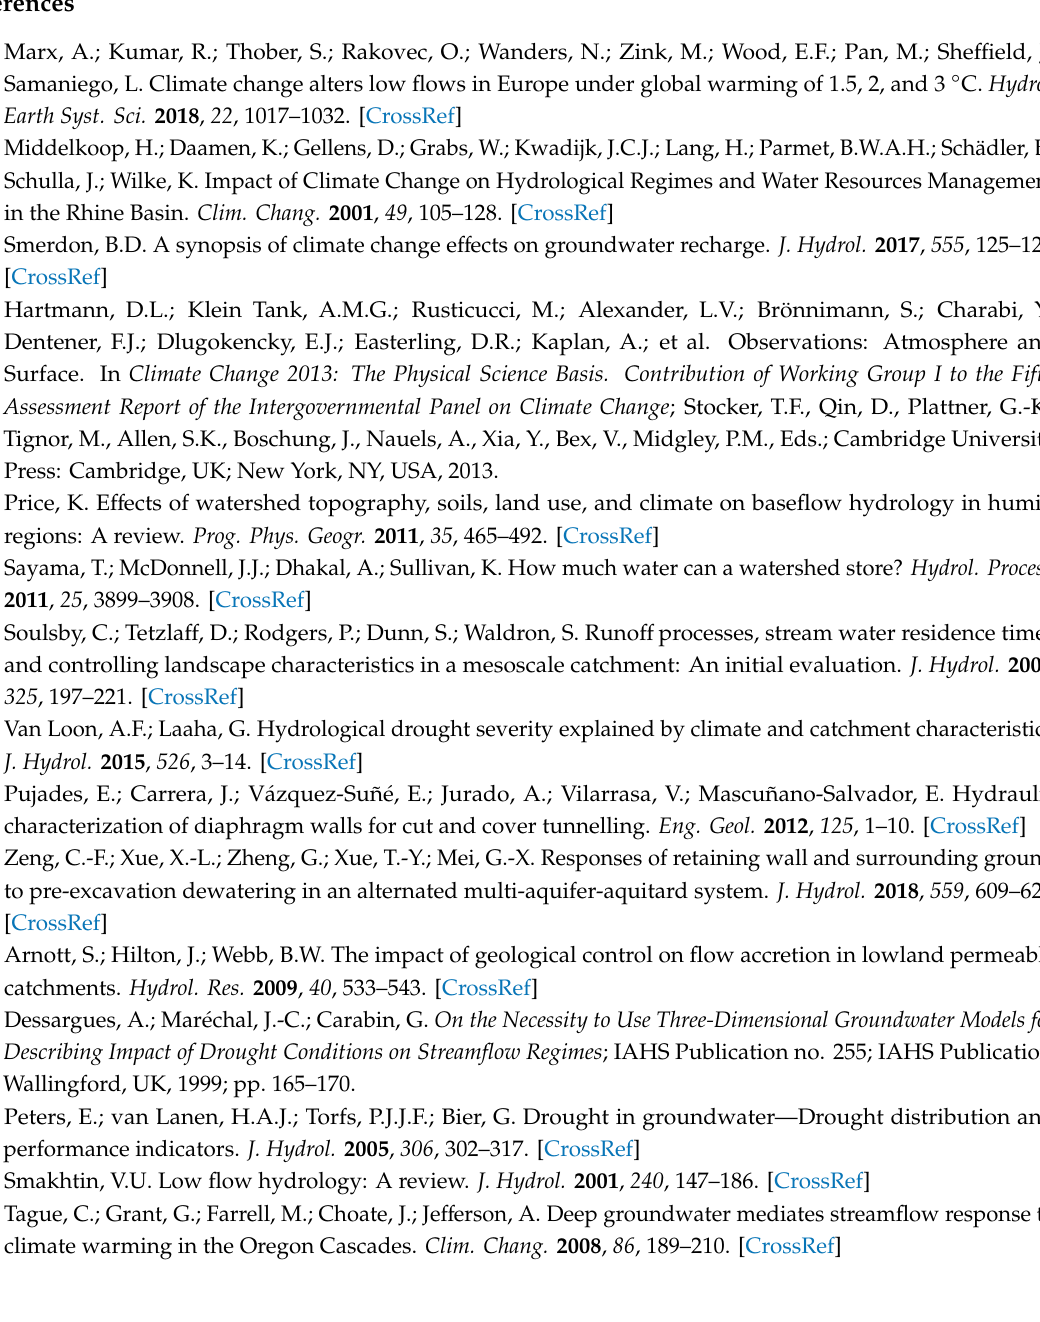
Table S1: Compilation of depth information from 33 deep boreholes for constructing the OMM and USM thickness